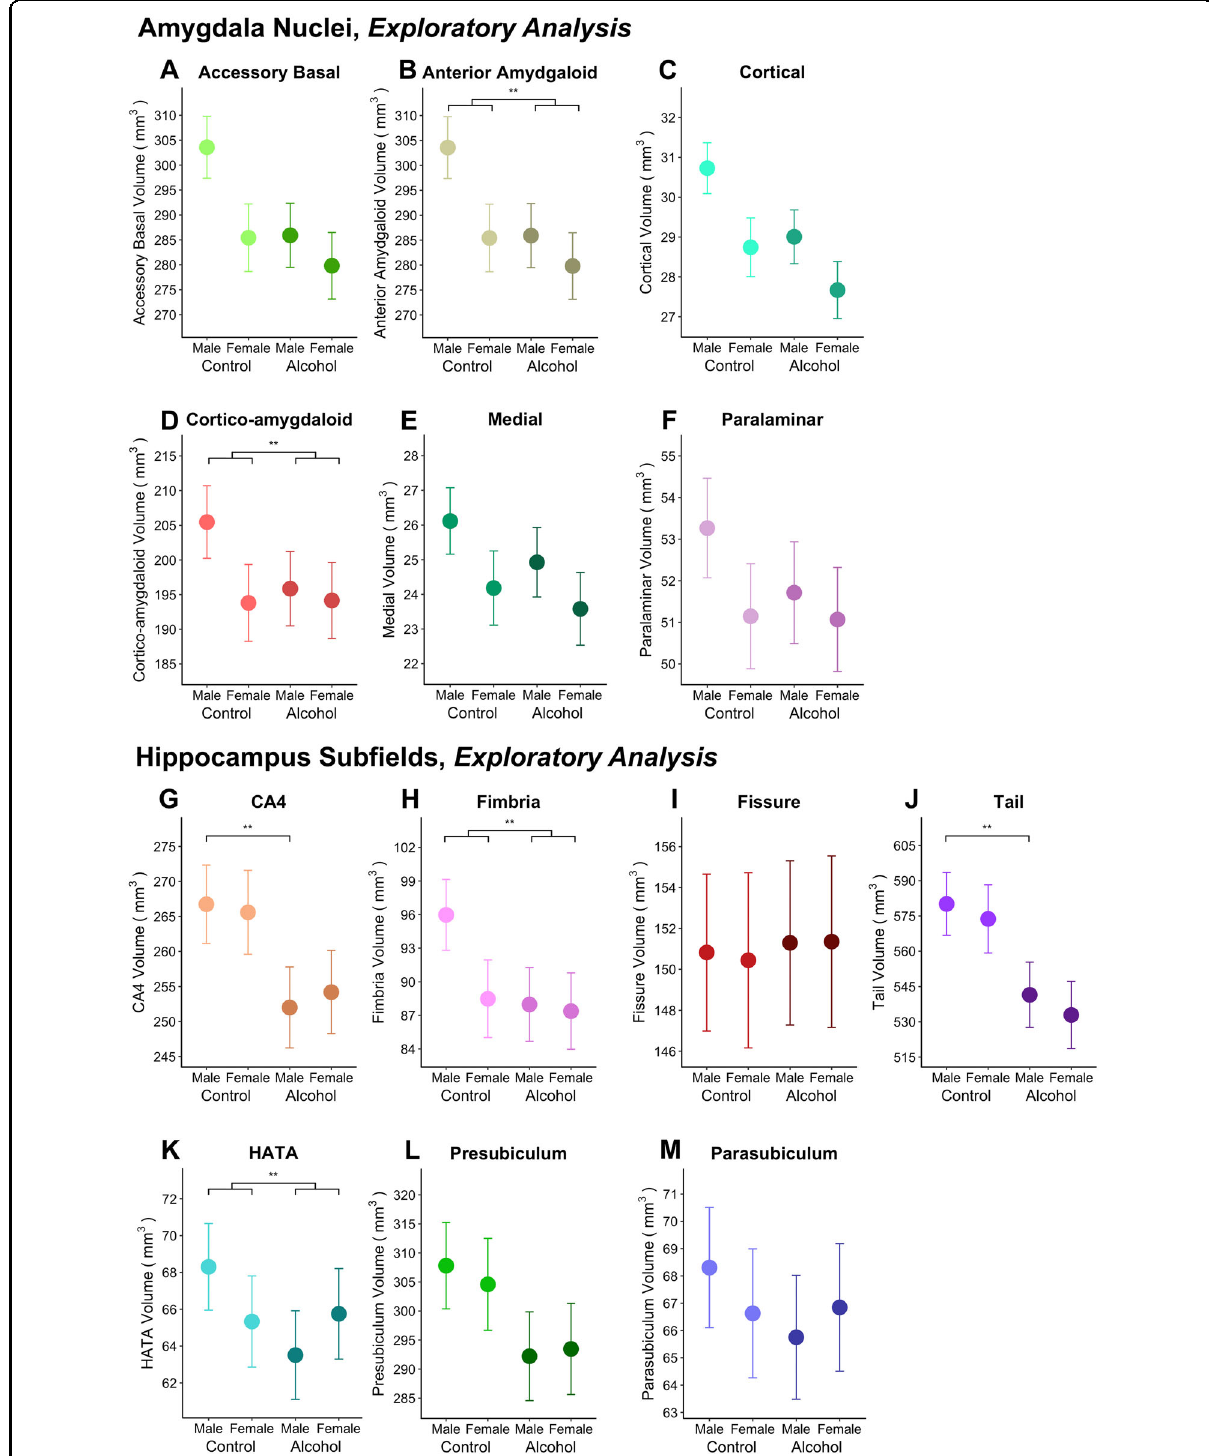
Fig. 2 Overview of group by sex effects on the volume of exploratory amygdala nuclei and hippocampus sub fi elds. Plots showing the estimated marginal means predicted by the model for the exploratory amygdala nuclei A accessory basal nucleus, B anterior amygdaloid transition area, C cortical nucleus, D cortico-amygdaloid transition area, E medial nucleus, and F paralaminar nucleus; and hippocampus sub fi elds: G cornu ammonis 4 (CA4), H fi mbria, I fi ssure, J tail, K hippocampal-amygdaloid tranisiton area (HATA), L presubiculum and M parasubiculum. The left and right hemispheres for the nuclei have been collapsed. Error bars represent the standard error of the marginal mean. ** p (FDR) <